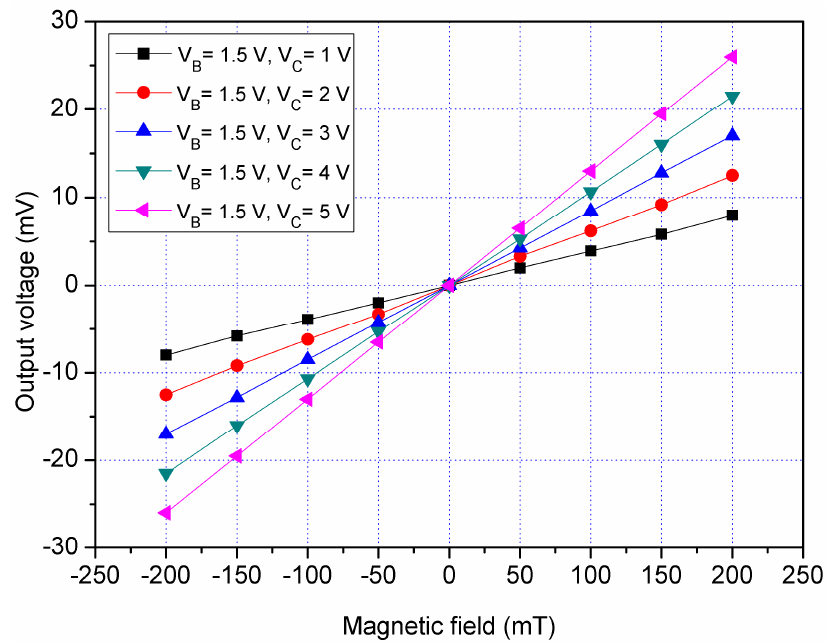
Figure 5. Simulated Vo in the z-direction MF.